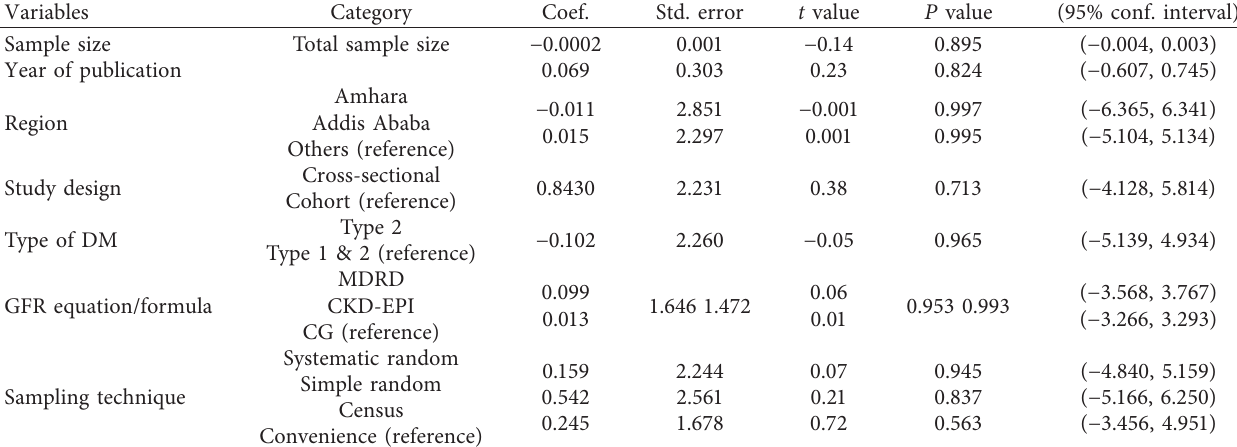
Table 4: Metaregression analysis for the included studies to identify the source(s) of heterogeneity. Variables